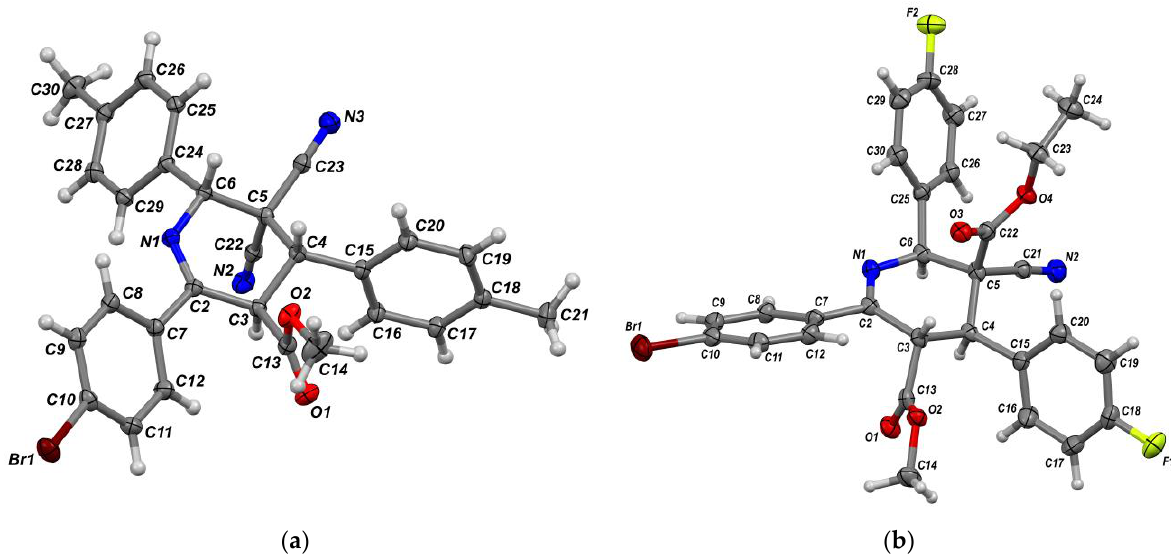
Figure 5. ( a ) X-ray structure of the 7 3 RS ,4 SR ,6 RS configuration; ( b ) X-ray structure of the 8 3 SR ,4 RS ,5 SR ,6 SR configuration.